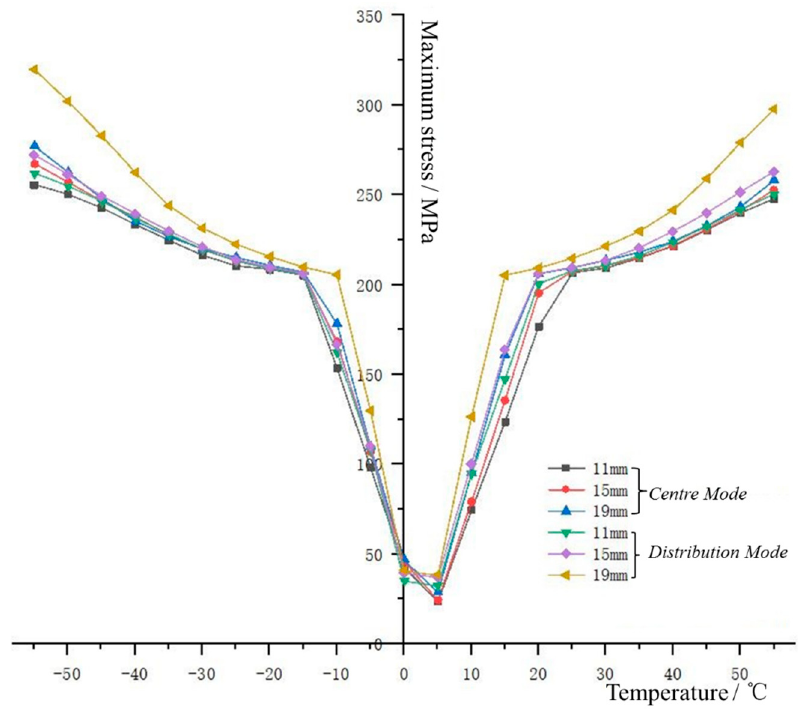
Figure 7. Temperature–stress curve of corrugated pipe with different wall thicknesses.